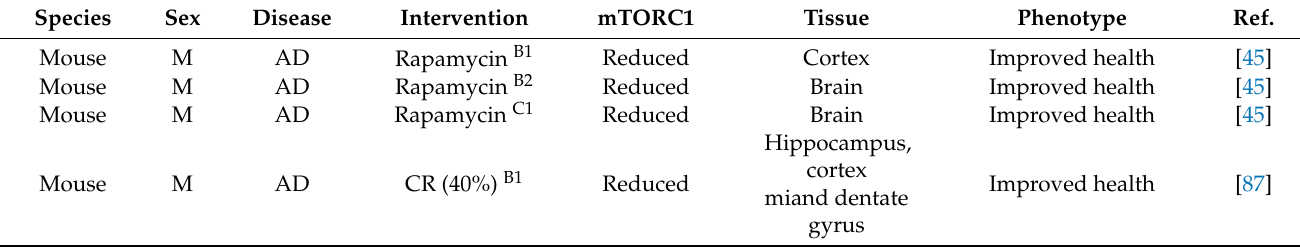
Table 6. mTOR regulation through nutritional interventions in pathological processes. Increased or reduced mTOR content can refer to transcript content, gene expression, protein content, protein phosphorylation or activity after insulin stimulation. Letters refer to: maximum longevity